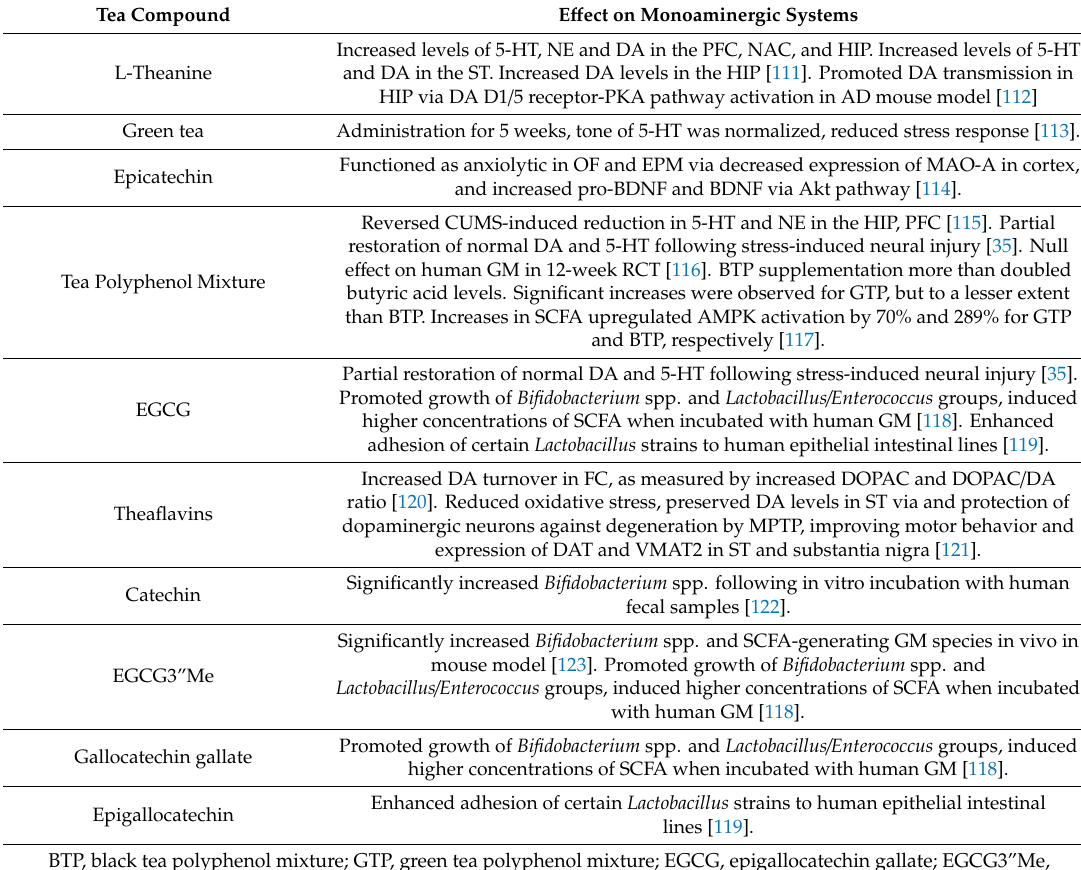
Table 3. Various tea compounds and their e ff ects on monoaminergic